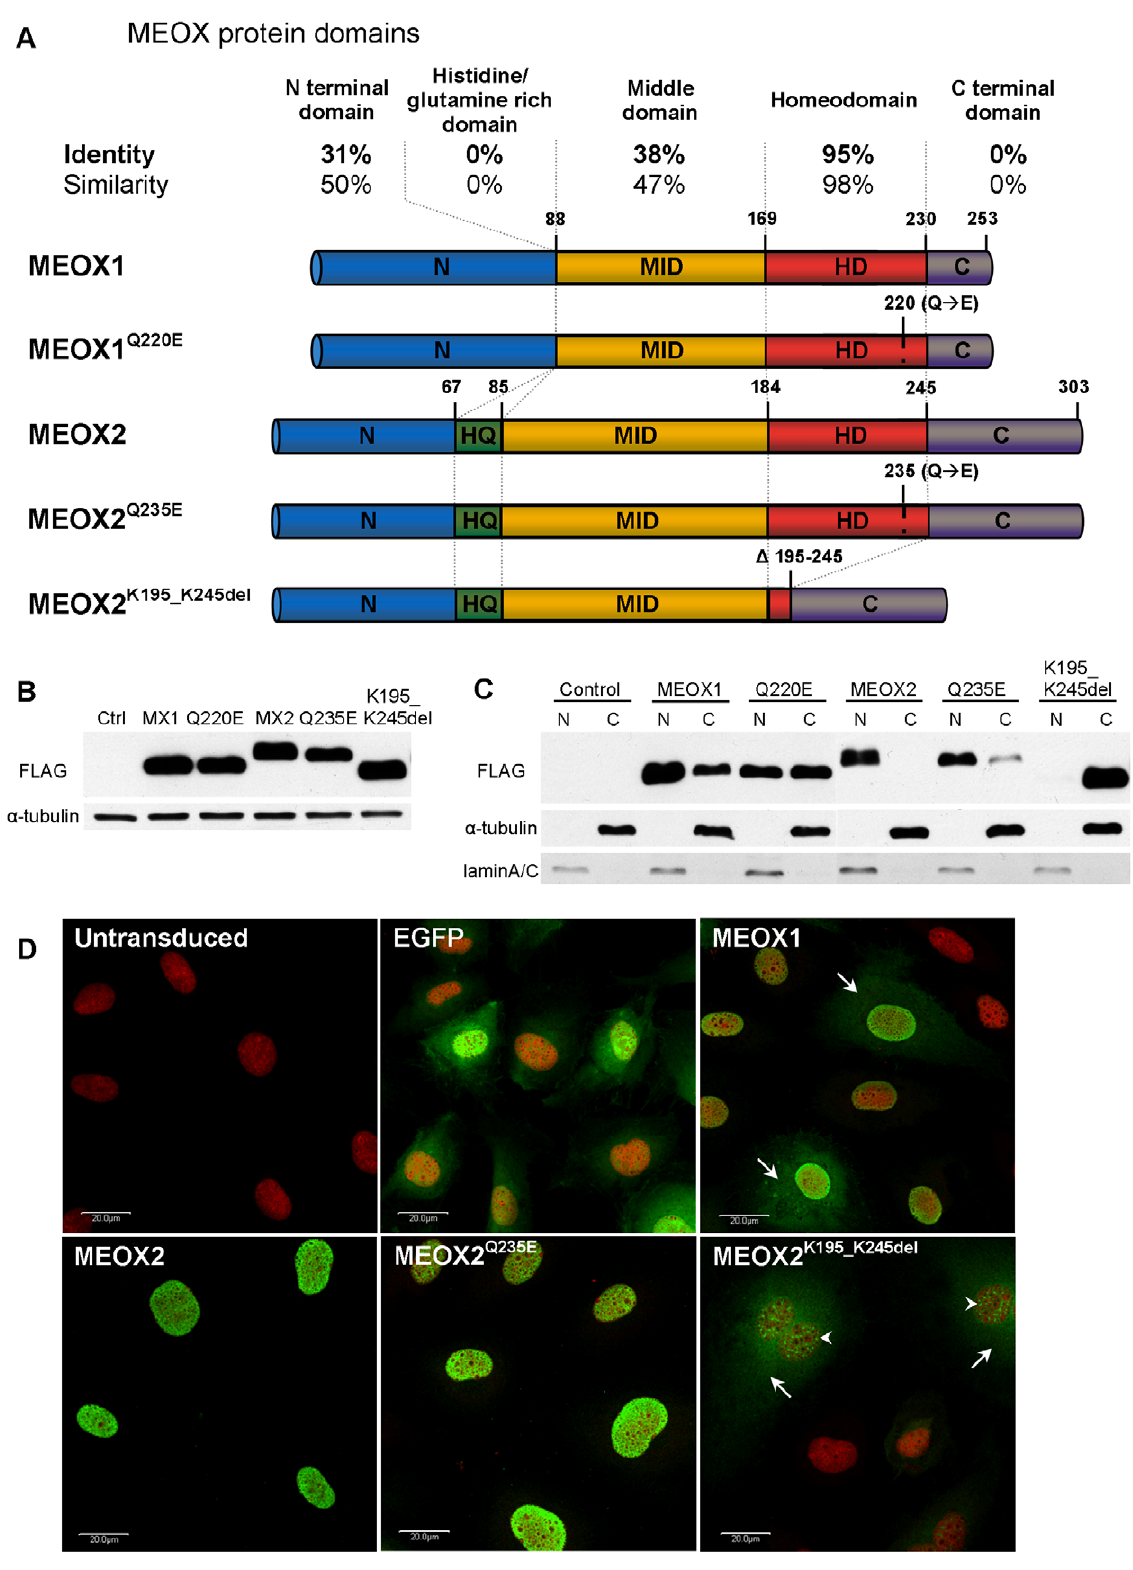
Figure 1. Expression and subcellular localization of MEOX1 and MEOX2 proteins. A) Schematic representation of the MEOX1 and MEOX2 protein constructs used in this paper. The alignment lists the percentage of similar and identical amino acids conserved between human MEOX1 and MEOX2 in the different functional protein domains. B) Representative western blot displaying the relative level of MEOX1 (MX1), MEOX2 (MX2), DNA binding deficient MEOX1 Q220E (Q220E), DNA binding deficient MEOX2 Q235E (Q235E) and homeodomain deleted MEOX2 K195_K245del (K195_K245del) protein expression in HEK293 cells 48 hours after transfection. The N-terminally tagged MEOX proteins were detected using an anti-FLAG antibody